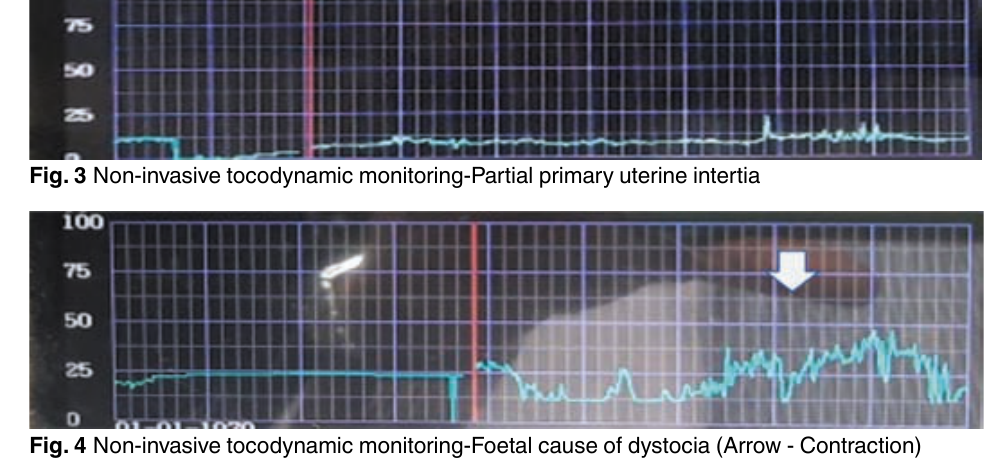
Fig. 4 Non-invasive tocodynamic monitoring-Foetal cause of dystocia (Arrow -